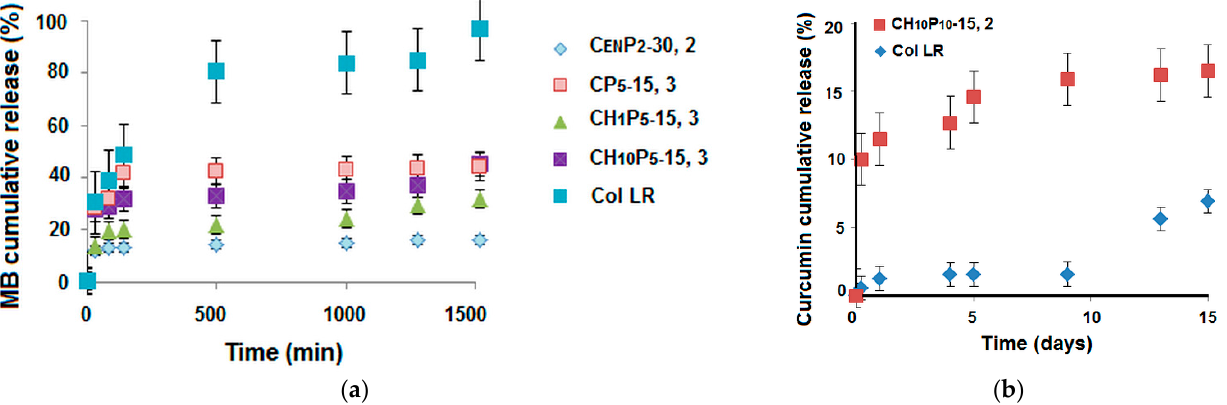
Figure 8. Cumulative release profile for representative MB-loaded ( a ) and CU-loaded ( b ) collagen-based sponges.